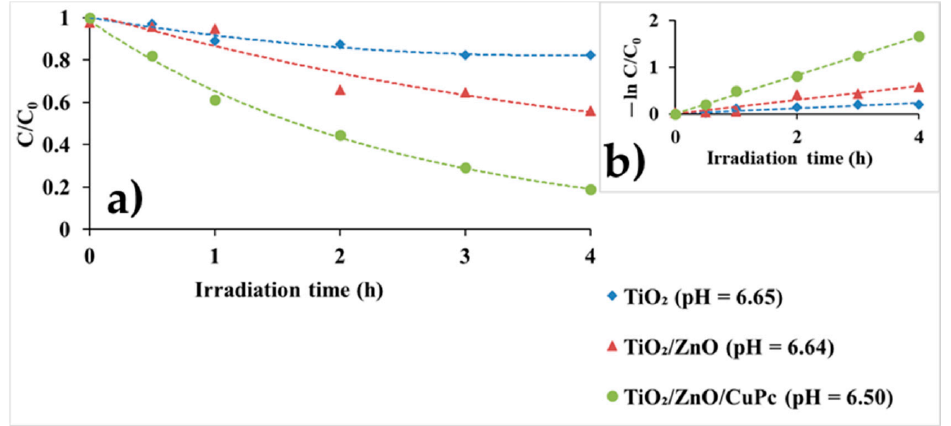
Figure 7. Photocatalytic degradation of 5 mg/L Ibuprofen by ( a ) TiO 2 , TiO 2 /ZnO, and TiO 2 /ZnO/ CuPc at respective natural pH values, and ( b ) corresponding degradation rate constant.